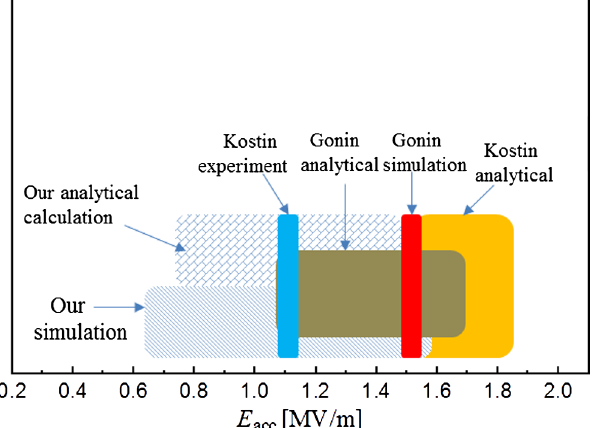
FIG. 10. Summary of zone 1 MP in the TESLA-style cavity HOM coupler. The Kostin experiment data did not give the MP field range in Ref. [25], so we use a narrow bar to represent the data point. The gradient width of Gonin simulation result was also not reported. A narrow bar was used to represent the data